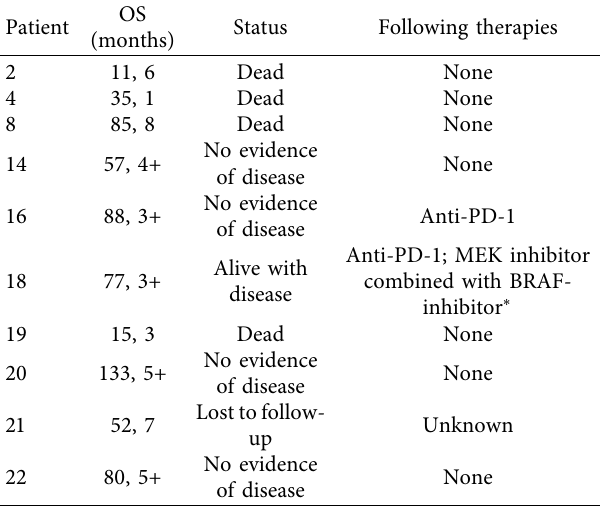
Table 5: Patients with cutaneous melanoma after first